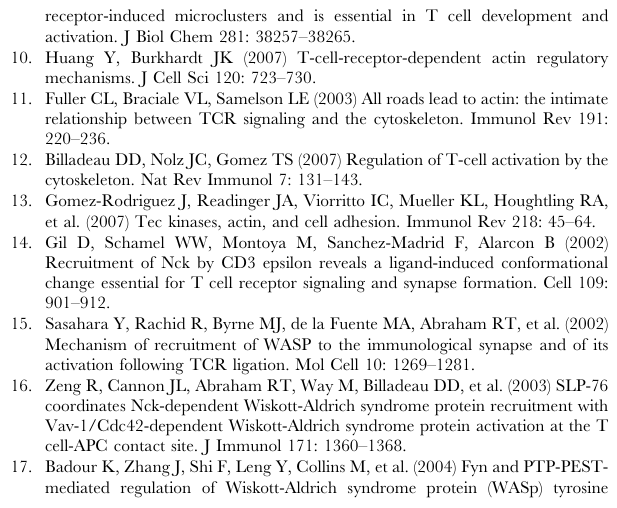
Figure S2 Vav1 microcluster formation is induced by TCR stimulation. Live J.Vav cells expressing GFP-only, or J.Vav1WT cells were incubated on coverslips coated with anti-CD3 antibodies, or with poly L-lysine and imaged in real time using TIRFM. Figure S3 Vav1 colocalizes with SLP-76 in TCR-induced microclusters. J.Vav, J.Vav1WT, or J.Vav1GEF- cells were activated on anti-CD3-coated coverslips for 2 minutes followed by fixation and permeabilization. SLP-76 microclusters were visualized by staining with anti-SLP-76 antibodies followed by anti-rabbit-Cy5. Vav1 microclusters are GFP + . Images were